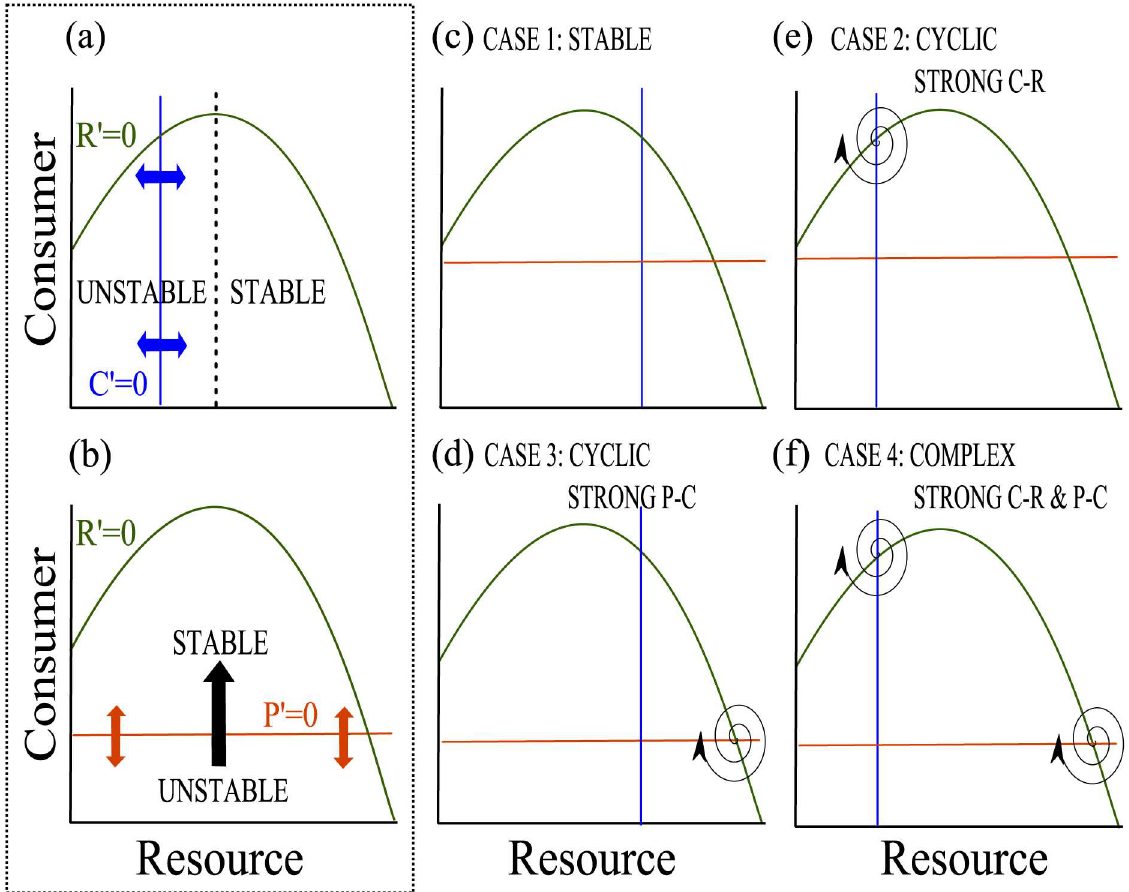
Fig 2. The predator, consumer, and resource isoclines of the food chain module. The locationof the intersections of resource(R’), consumer (C’), and predator(P’) isoclineson reducednullsurface of a food chain module,which is a projectionof all zero isoclinesonto the C-R plane, is directly related to the stability of the food chain. The C-R interactionis unstable when C’ lies to the left of the resourceisocline hump and is stable when to the right of the hump (a). Similarly, when P’ is pushed from high to low C densities,the potentialto drive P-C oscillations(depictedin this figure as an outwardlyspiralingarrow) increases(b). All parameter combinations are representedin one of four basic cases: stable food chain (c), cyclic food chain where the cycle is driven primarily by a strong consumer-resourceinteraction(d), cyclic food chain where the cycle is driven primarilyby a strong predator-consumer interaction (e) and, complex dynamicswhere the cycles are an interactionof strong consumer-resource and strong predator- consumer